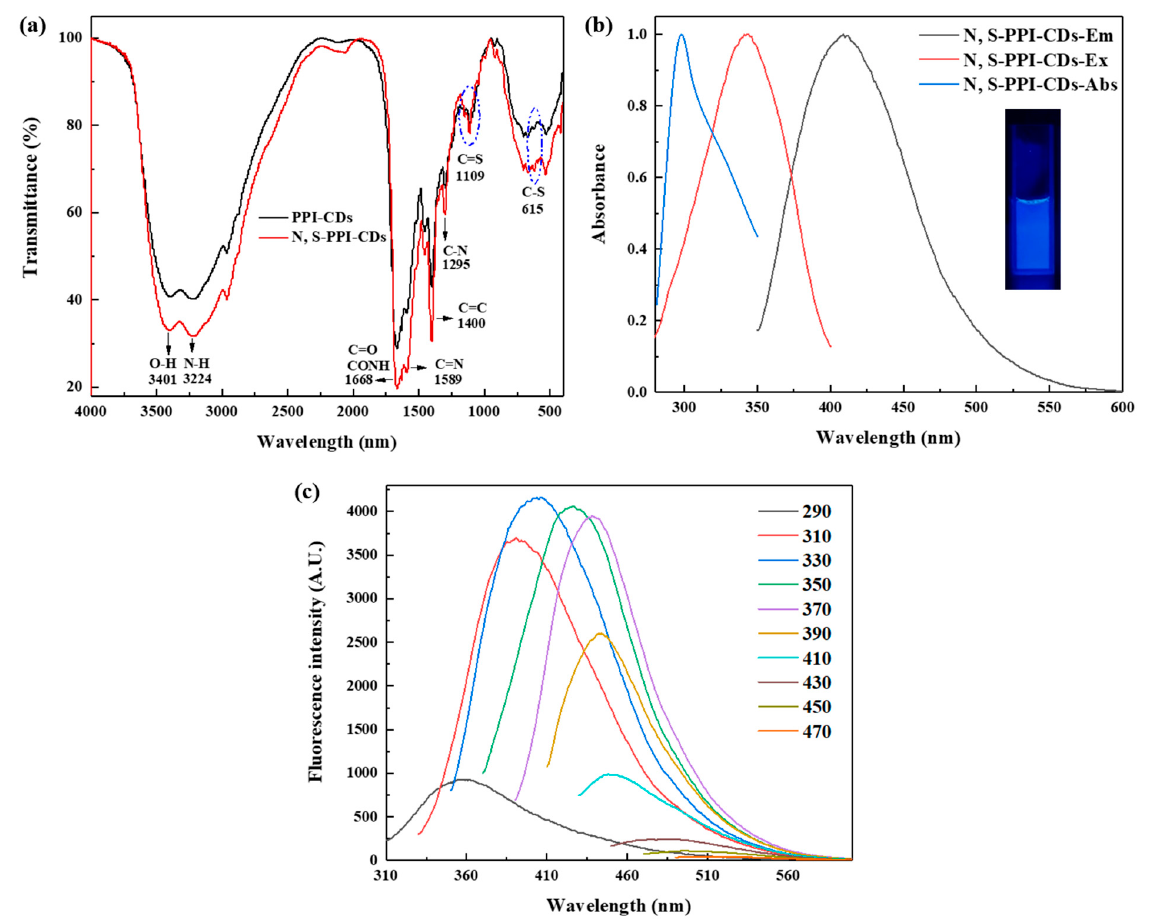
Figure 1. ( a ) FTIR spectrum of PPI-CDs and N, S-PPI-CDs; ( b ) UV–vis absorption spectrum and fluorescence spectrum of N, S-PPI-CDs (Inset: photograph of N, S-PPI-CDs solution under UV (365 nm) irradiation); ( c ) emission spectrum of N, S-PPI-CDs with the excitation wavelength increased from 290 to 470 nm at 20 nm intervals.